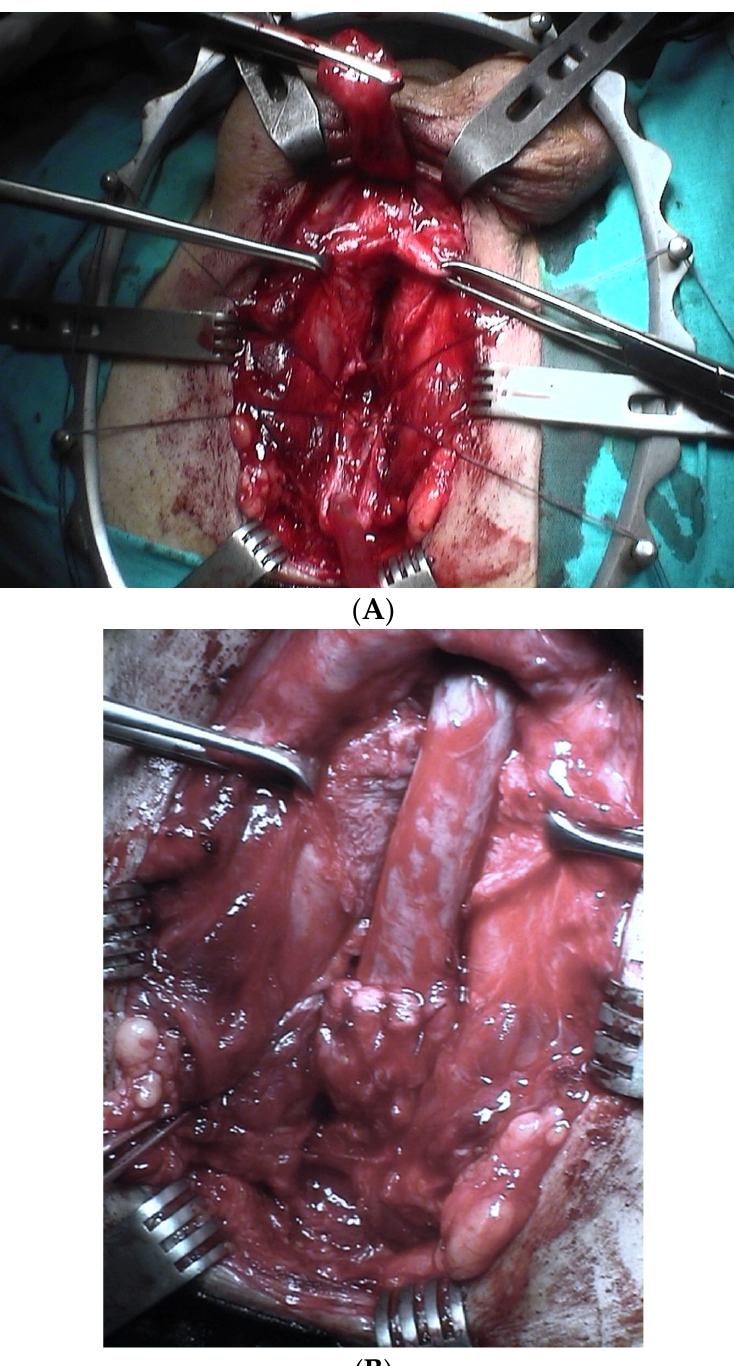
Figure 2. ( A , B ) Corporal body separation.